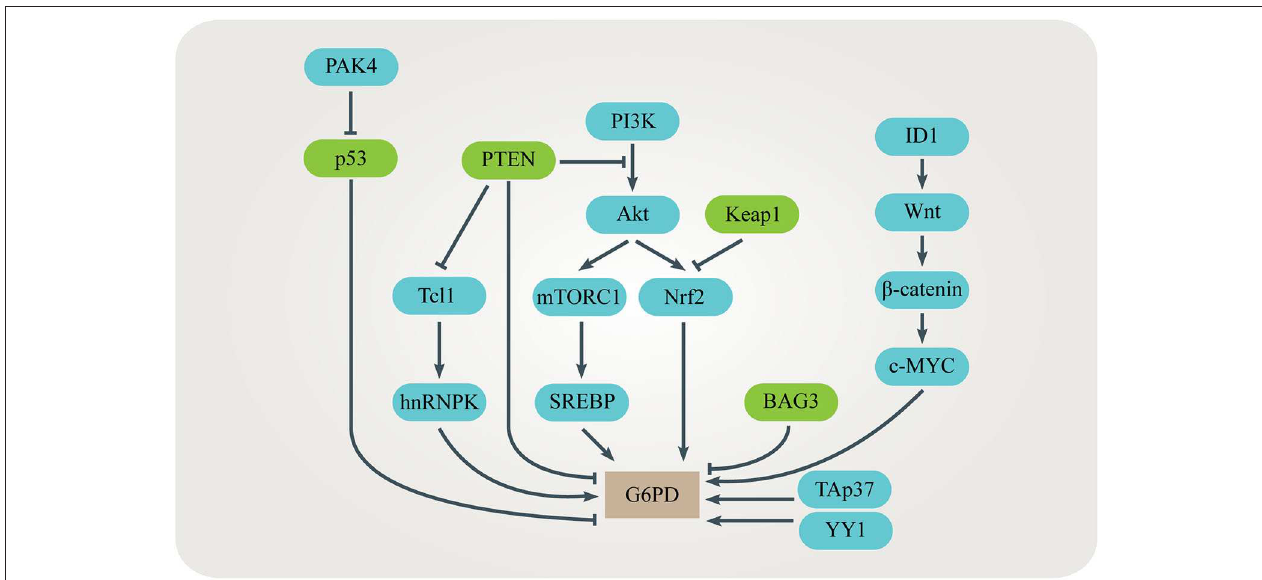
FIGURE 4 | Regulation of G6PD in cancers. Several signaling pathways have been identified to be responsible for promoting G6PD expression or activity in cancer cells. These signaling pathways interact with each other, adding complexity to the regulation of G6PD.